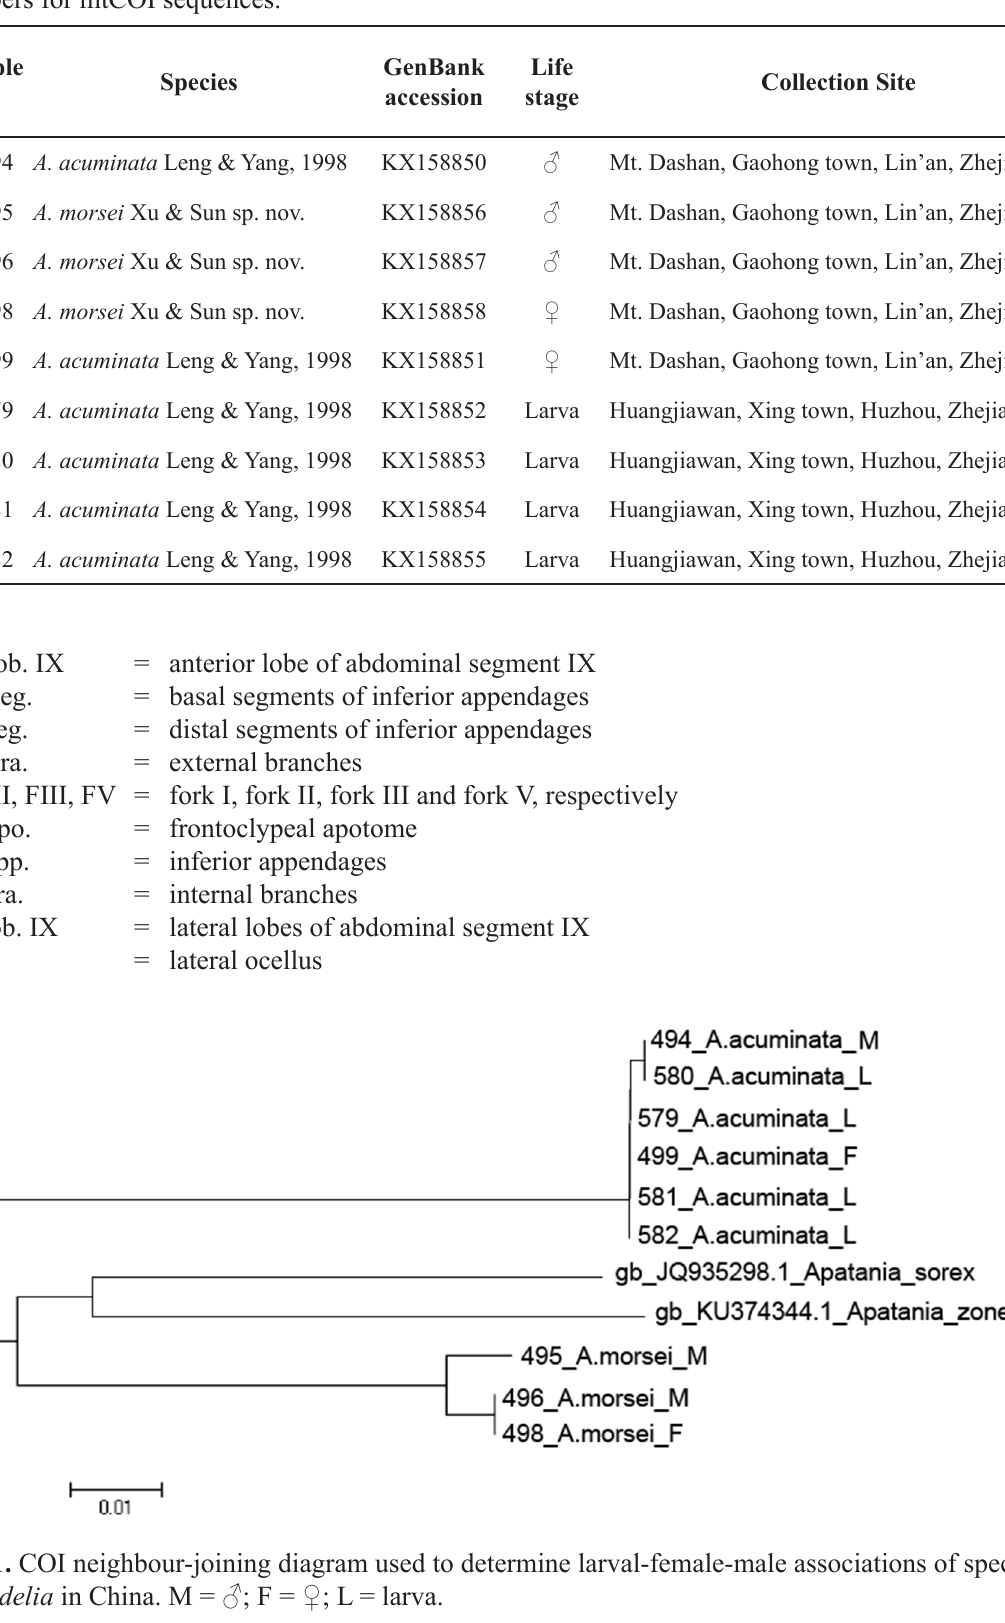
Table 1. Specimens used in larva-female-male associations of Apatidelia , with GenBank accession numbers for mtCOI sequences.